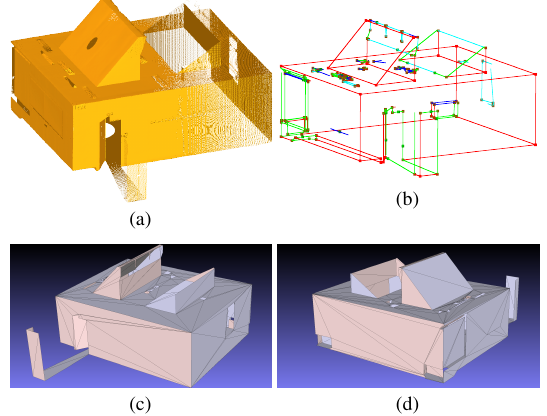
Figure 13. 3D reconstruction of a classroom (a): LiDAR 3D point cloud. (b) Segments and corners. The edge labels are: intersection (red), occlusion (green), interaction with object (blue) and opening (cyan). The corner labels are: intersection of 3 planes (red), intersection of 2 segments (brown). (c), (d): mesh model